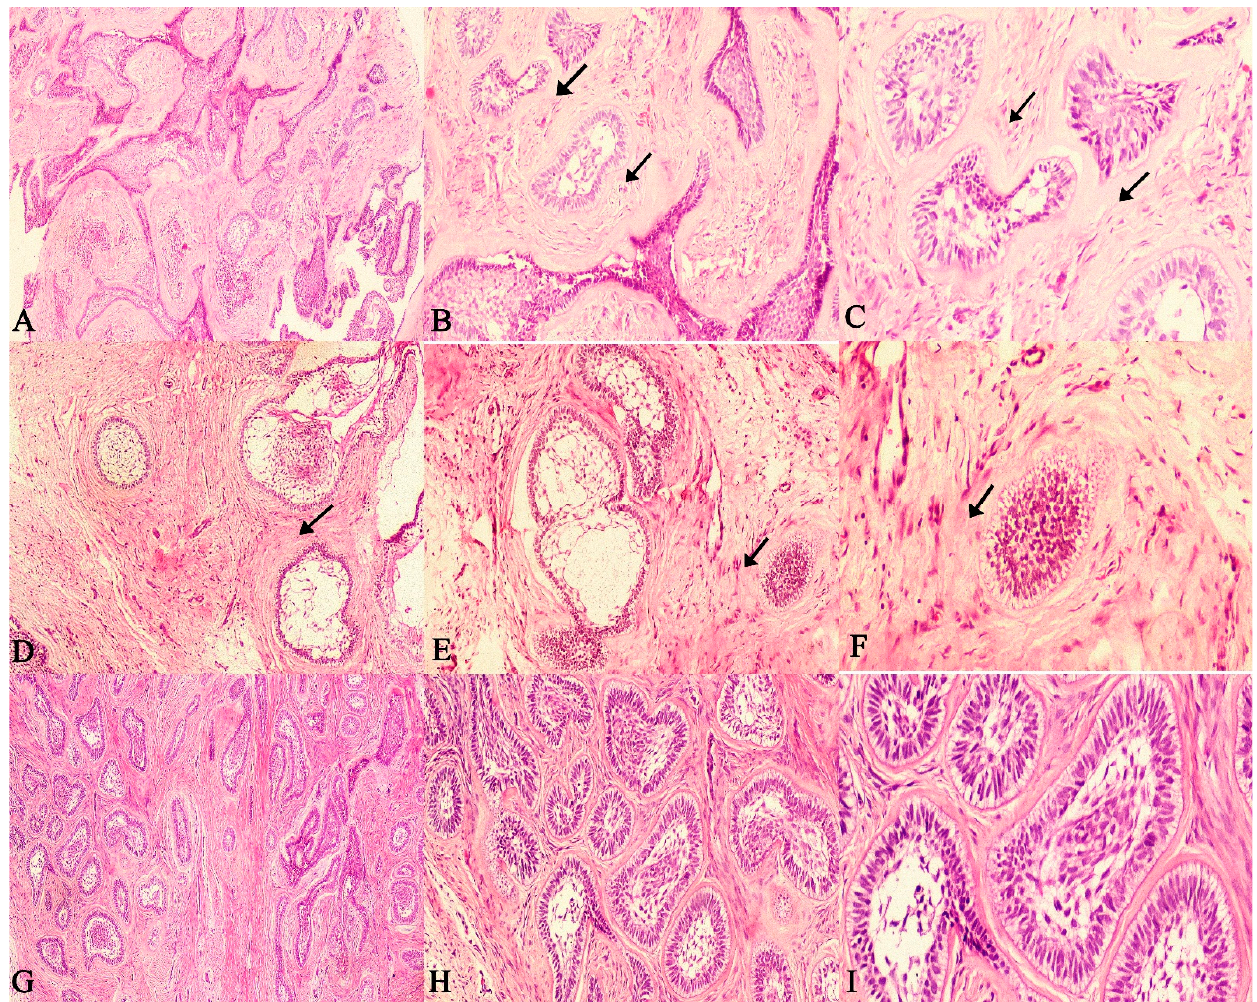
Figure 4. Photomicrographs of haematoxylin and eosin stain. Follicular ameloblastoma exhibiting extensive (increased SOH) juxta-epithelial and stromal hyalinization zones between follicles ( A ). 40 × , ( B ). 100 × and ( C ). 400 × (recurrent case). Follicular ameloblastoma exhibiting (moderate SOH) juxta-epithelial and stromal hyalinization zones between follicles ( D ). 40 × , ( E ). 100 × and ( F ). 400 × (recurrent case). Follicular ameloblastoma exhibiting (mild SOH) juxta-epithelial and stromal hyalinization zones between follicles ( G ). 40 × , ( H ). 100 × and ( I ). 400 × (non-recurrent case). (Non-hyalinized: no evidence of hyalinization; mild: few areas of hyalinization; moderate: considerable areas of hyalinization; severe: extensive areas of Hyalinization). (Arrows indicate hyalinized areas). The majority of recurrent SMA cases showed an intense SOH. The findings also reiter- ate the fact that the histologic variant does not appear to influence the recurrent potential of SMAs, rather it is the feature of hyalinization that seems to distinguish aggressive and non-aggressive cases. (Figure